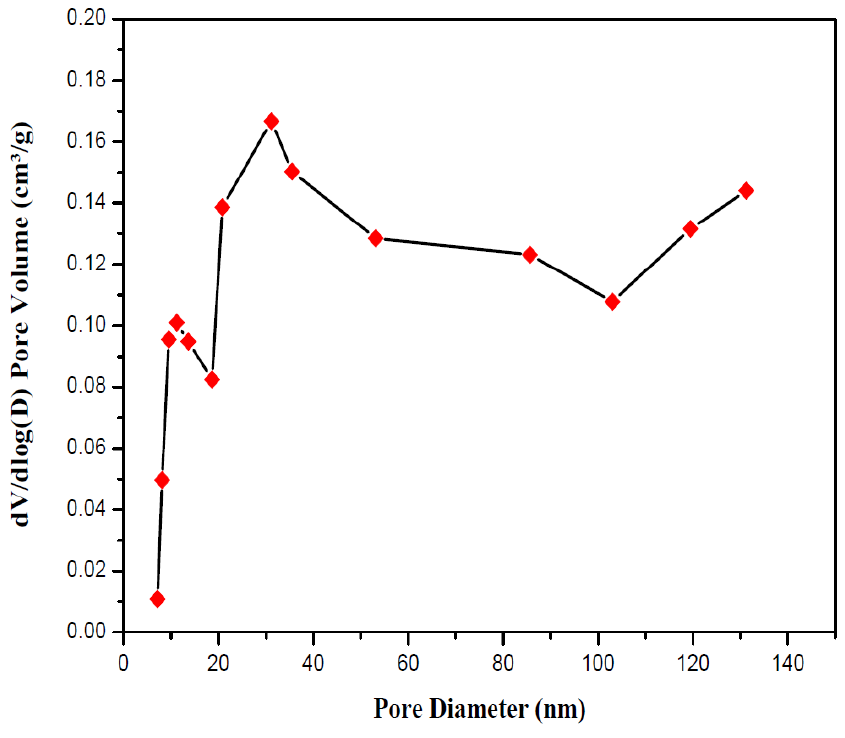
Figure 9. Pore size distribution of SNPs.